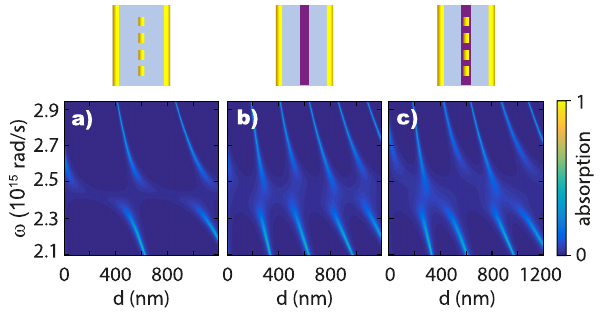
Figure 12: Absorption as function of frequency and etalon spacing for etalons in which either a plasmonic metasurface is placed (a), assuming same antennas as in Figures 2 – 5, at pitch 350 nm), or excitonic material (b), a 200 nm thick layer of J-aggregate), or both (c).Intheplasmoniccase,onlythesymmetricmodesarevisible,and show strong coupling. In the tripartite case (c), the Rabi splitting for those modes exceeds that achieved in either (a) or (b). Note that for this example mirrors were chosen